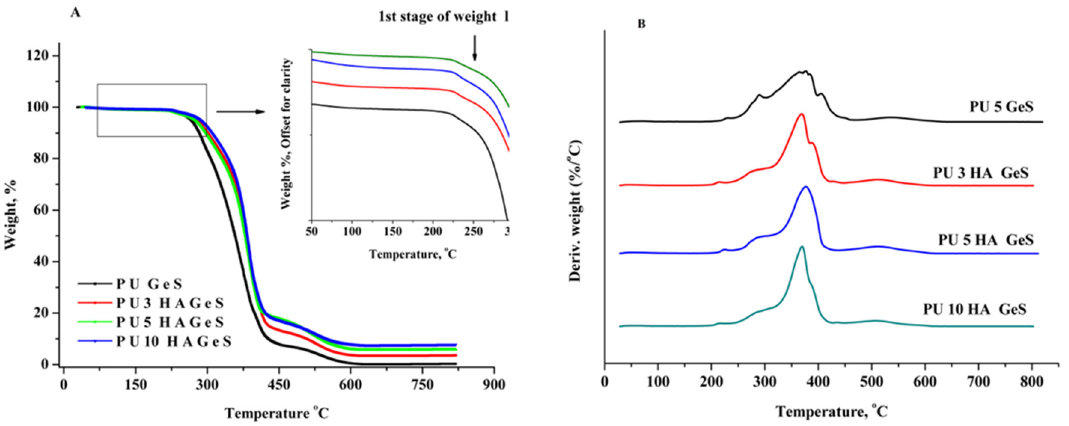
Figure 5. ( A ) TG and ( B ) DTG curves of PU composites, with GeS and various amounts of HA under air atmosphere. TG curves were shifted along Y-axis for clarity in the inset of Figure 5A and in Figure 5B. Table 2. The results of TGA analysis.